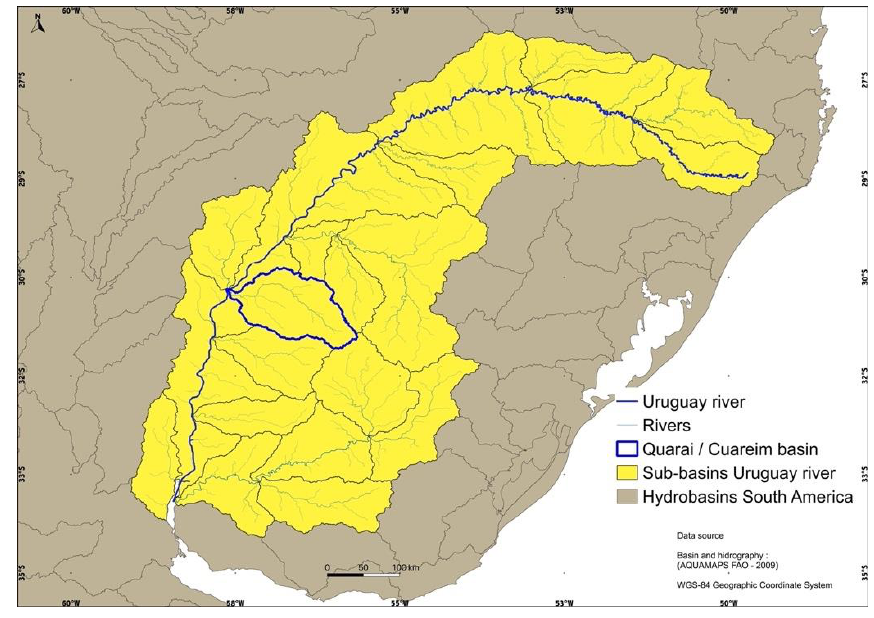
Figure 15. Selection (in yellow) of Uruguay River sub-basins.